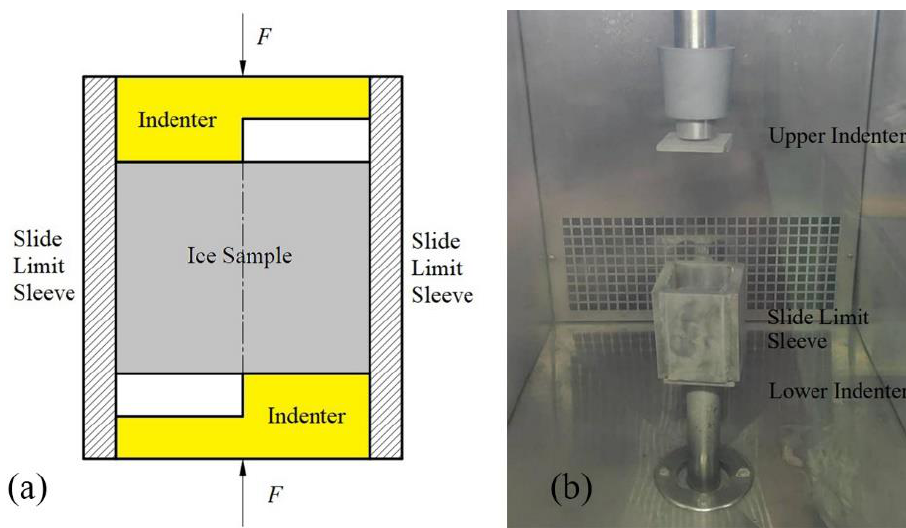
Figure 3. Shear strength test device. ( a ) Device diagram. ( b ) Device.